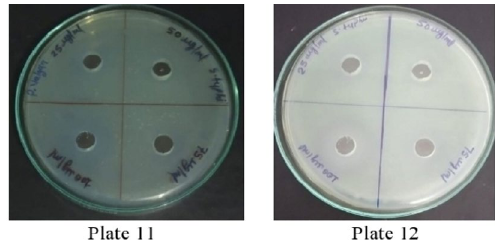
Fig. 9. Plate 11 & 12. Anti-Bacterial Activity of Methanolic Extract of P. vulgaris against S.